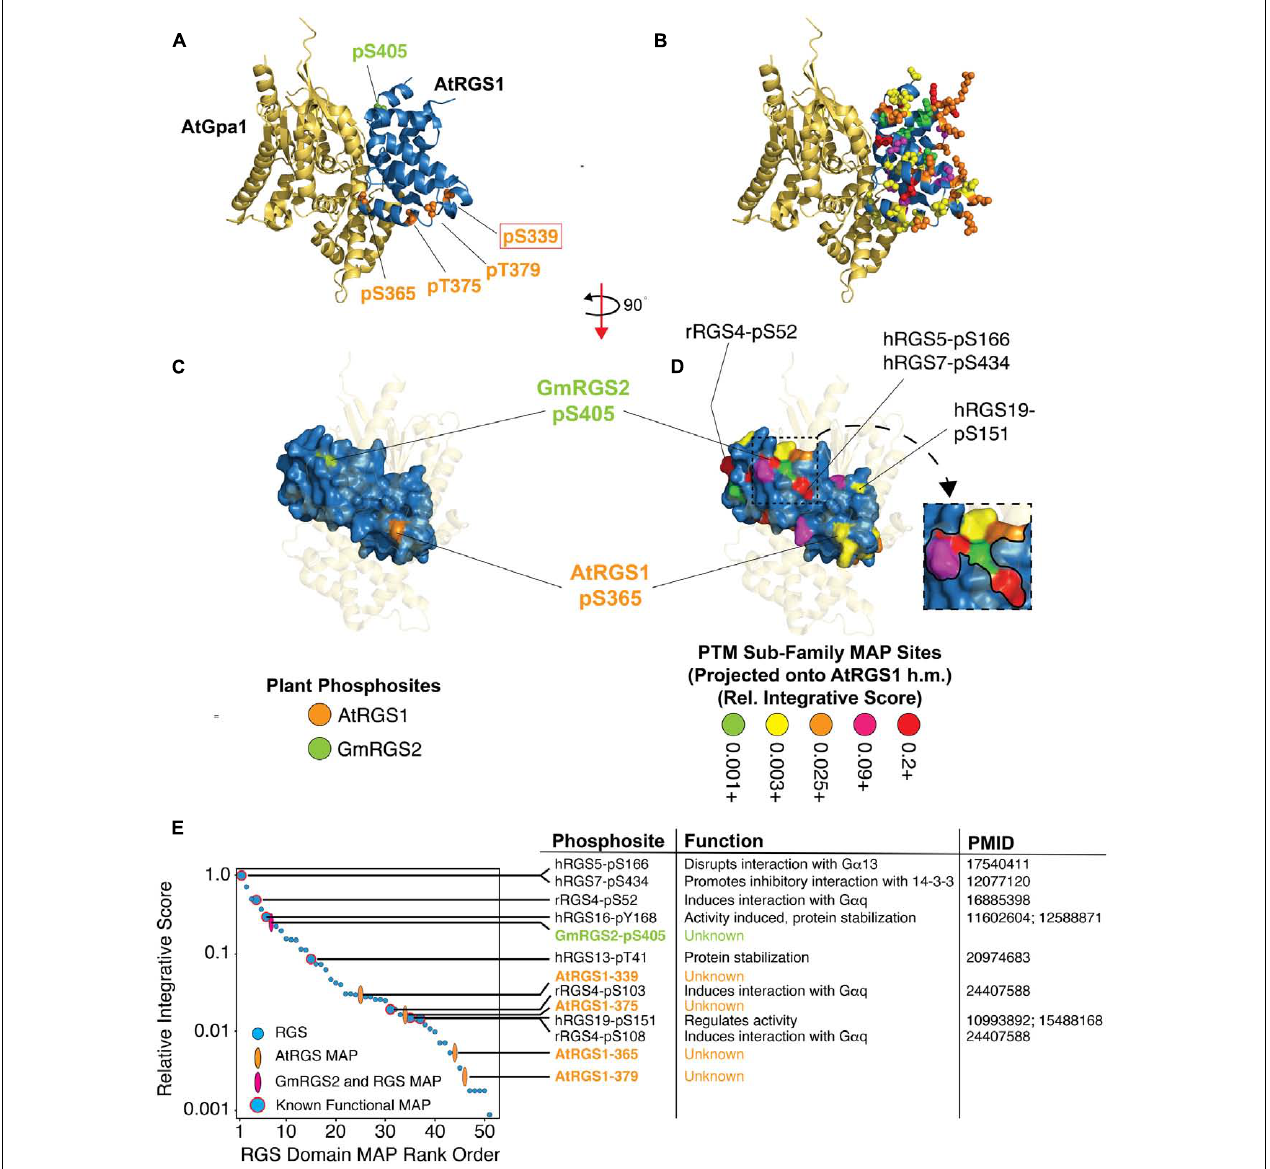
FIGURE 5 | Structural projection and quantitative rank ordering of plant and non-plant MAPs identifies potential functional roles for plant phosphosites. (A) Structural homology model of the RGS domain of AtRGS1 bound to the crystal structure of AtGPA1 (PDB: 2XTZ) with relevant plant phosphosite sidechains rendered as Van der Waals spheres. AtRGS1 phosphosites (orange) and GmRGS2 phosphosite (green). (B) Same as in (A) , but with the projections derived from non-plant and plant MAPs in the PTM sub-family. Color code corresponds to the relative integrative score (see E ). (C,D) Surface rendering of the RGS domain with corresponding structural projections shown in (A,B) , respectively. AtGPA1 is transparent and the structure rotated to reveal the G α binding surface of the RGS domain. Visible RGS domain PTMs that were established as biologically functional are indicated with labels showing the RGS protein and residue position of the functional PTM. (D-inset) Zoomed view of the surface PTM cluster containing GmRGS2-pS405. (E) The 51 MAPs within the RGS domain were rank ordered by a relative integrative score (methods) (right). Functional PTMs contained with each MAP are shown with a brief description of their functional role and the PubMed ID source of